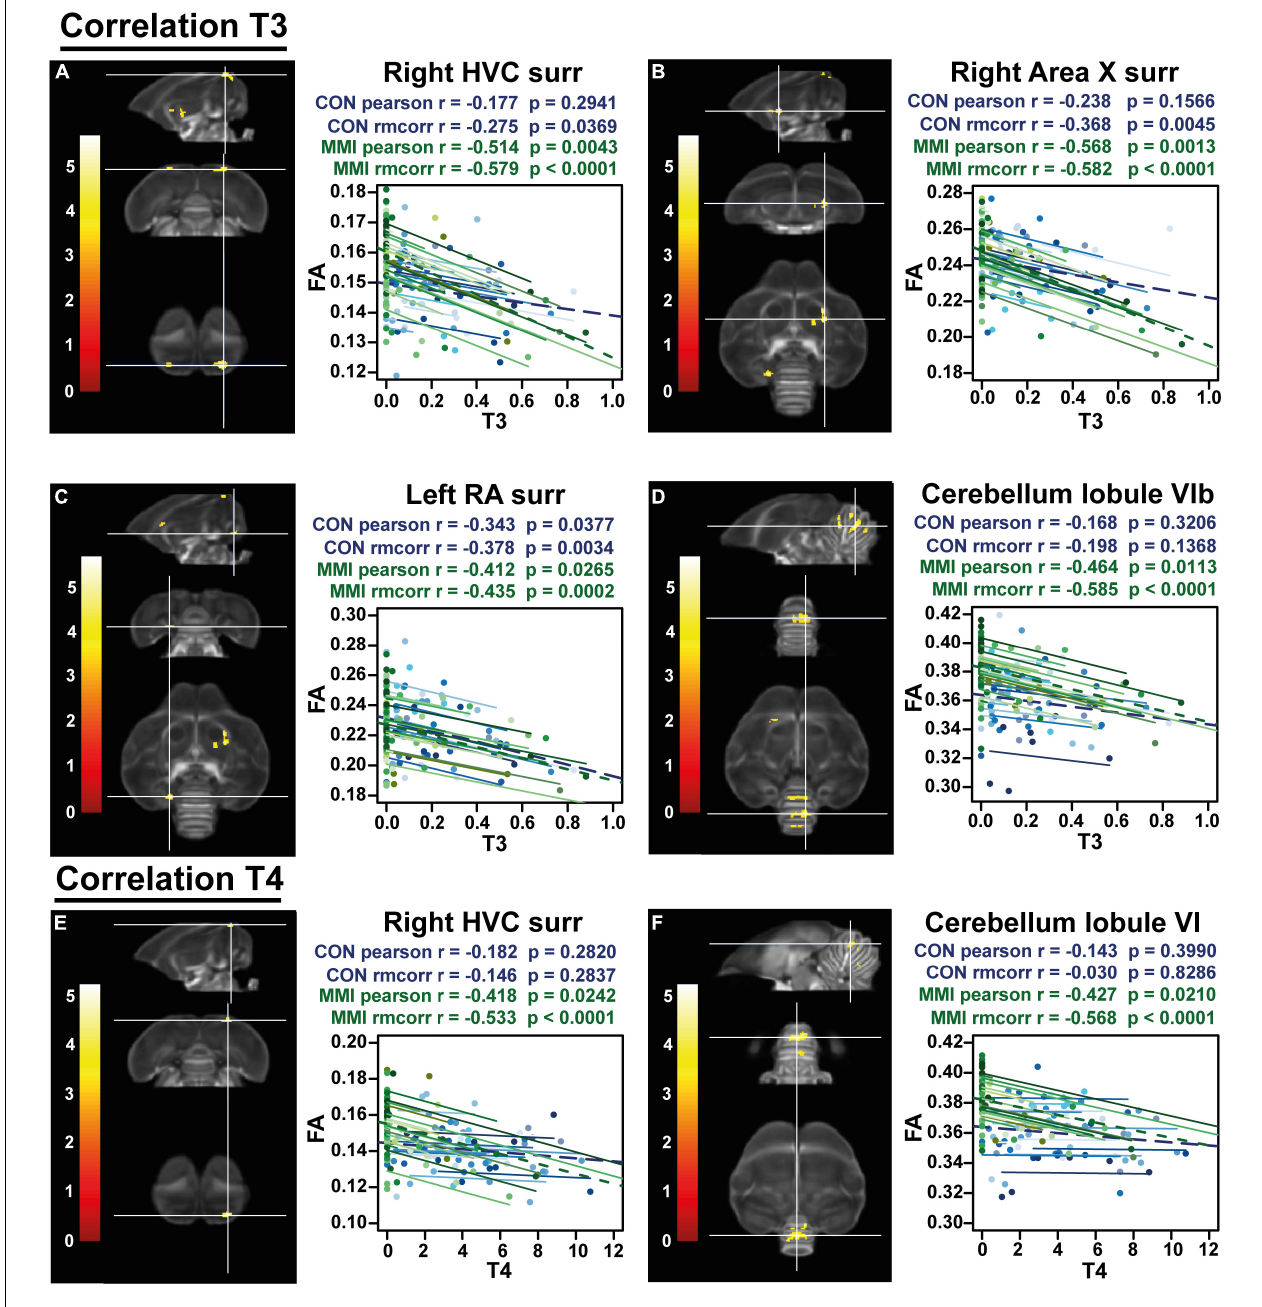
FIGURE 6 | Overview of structural neural correlates of thyroid hormones T3 (A–D) and T4 (E,F) levels to fractional anisotropy (FA) in both groups identified using voxel-based multiple regression. The statistical maps were assessed at p uncorr < 0.001 and k E ≥ 20 voxels with a small volume correction including regions of the song control system, white matter structures and the cerebellum. Significant voxels are color coded according to their T–values displayed on the scale on the left. Next to each statistical parametric map, the identified correlations were further explored with repeated measures correlation of the control group (blue) and MMI treatment group (green). Solid colored lines show the best linear fit for the within-subject correlation in the control group (blue) and MMI group (green) using parallel regression lines with different shades for individual animals. The blue and green dashed line represent the linear fit of the overall Pearson correlation representing the between-subject correlations of the control and MMI group respectively. For bilateral correlations, only the left side is shown. surr,